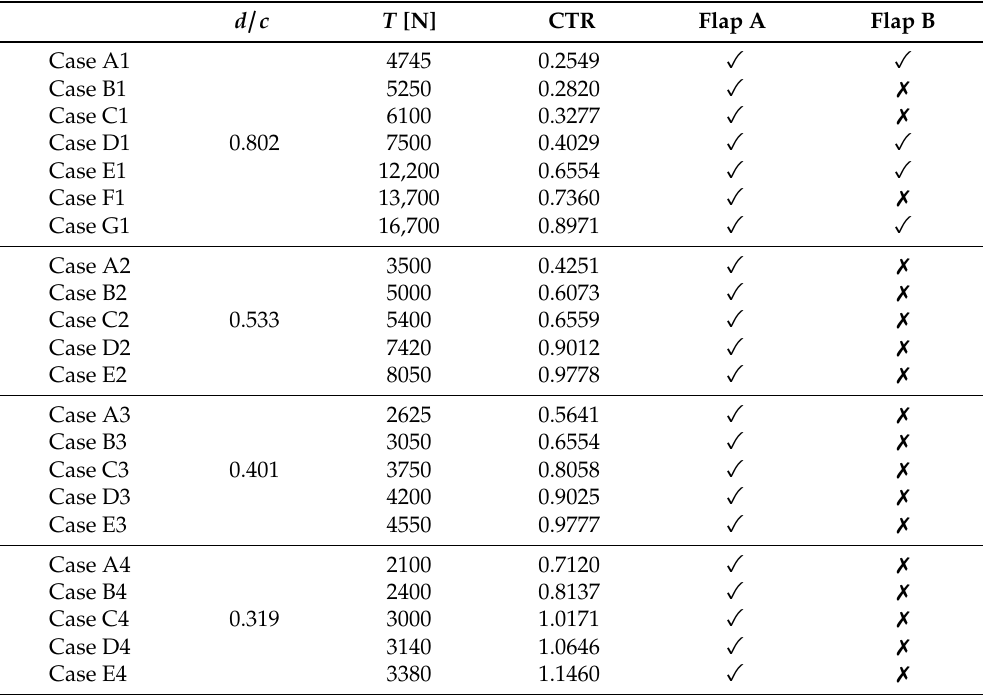
Figure 5. Increment of lift and drag coefficients for the test at V ∞ = 59.84 m/s ( ■ ) and V ∞ = 29.92 m/s ( ▲ ) . The corresponding tendency lines are in dashed ( ) . Table 2. Test cases